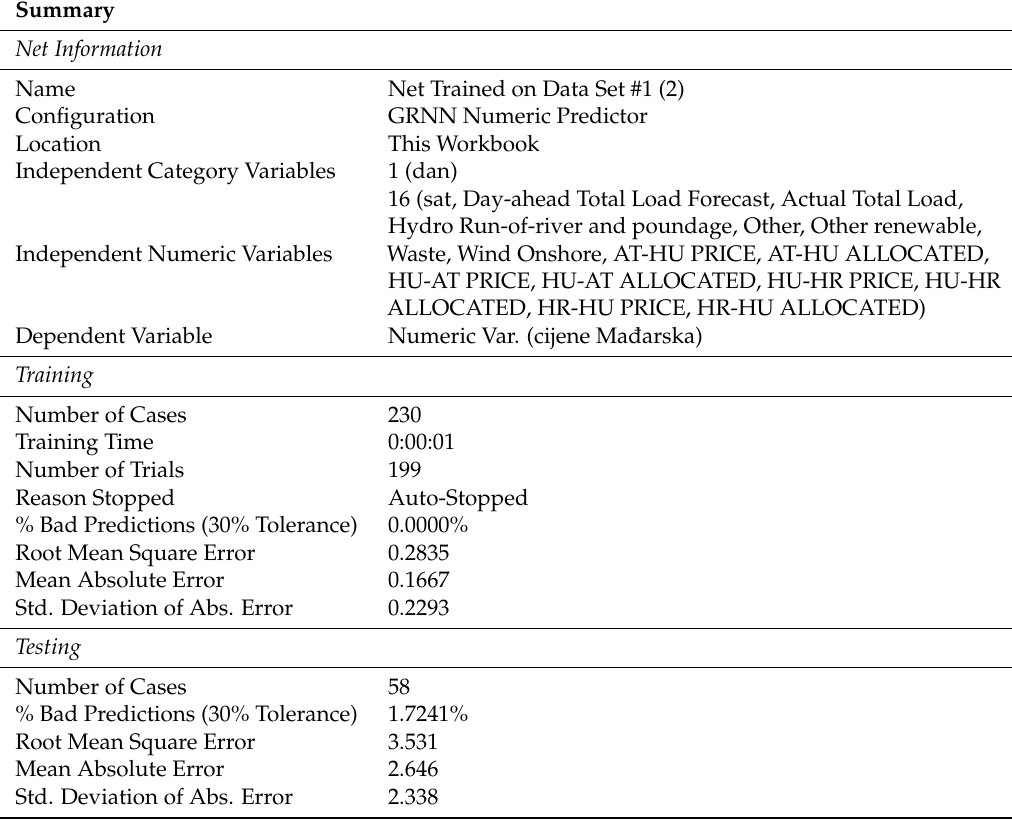
Table A2. Sensitivity analysis results for input parameters in the second